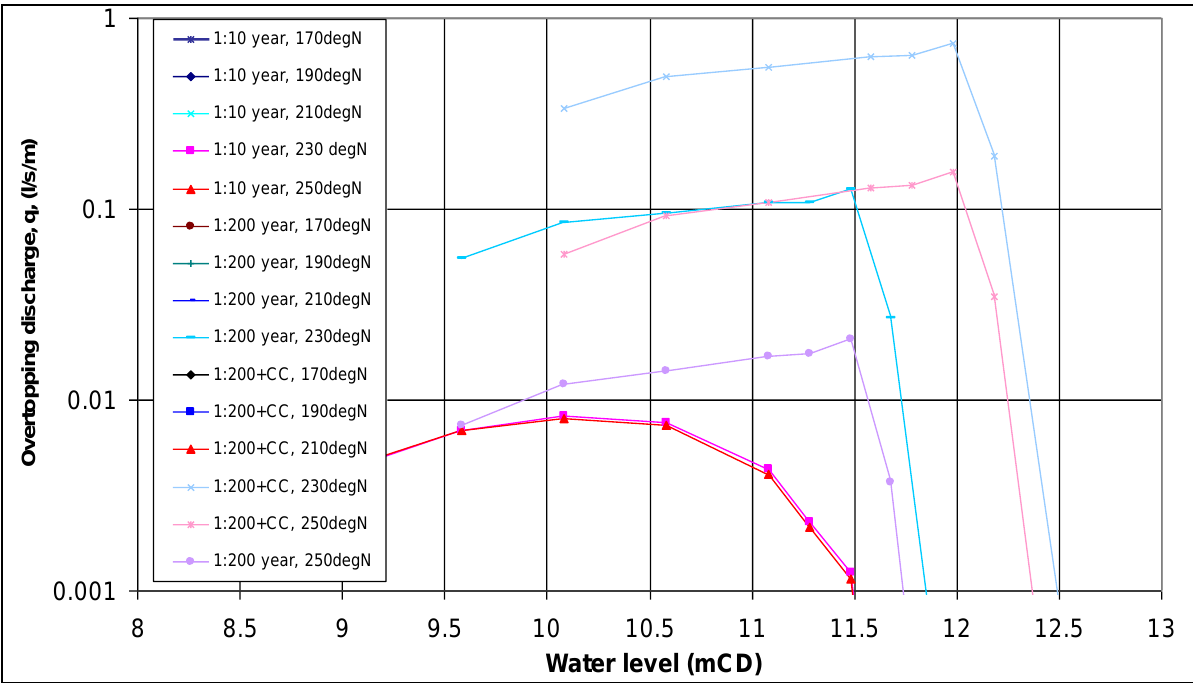
Figure 13. Overtopping at Position C1, wide crest at +19 mCD.